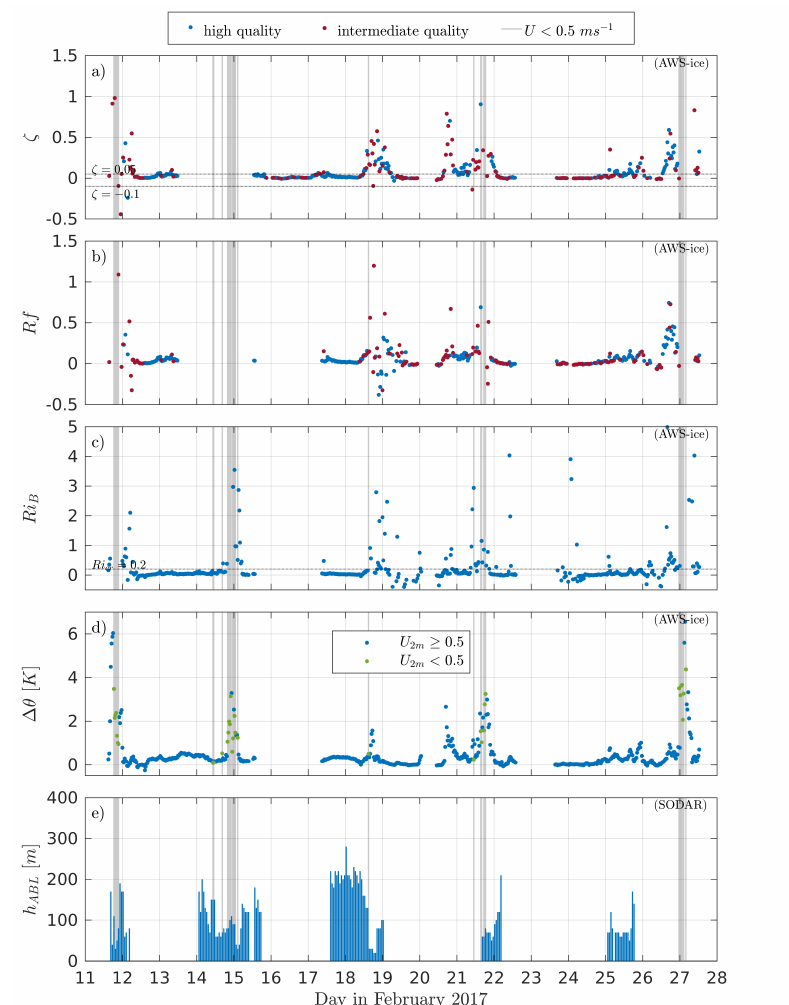
Figure 8. Time series of the stability parameters: ( a ) MO stabilty, ζ ; ( b ) flux Richardson Number, Rf ; ( c ) bulk Richardson Number, Ri B ; ( d ) the difference in potential temperature between the 4 m and 1 m levels, observed over the sea ice; and ( e ) the ABL height, h ABL , estimated from the SODAR (Sound Detection and Ranging) observations. The quality of the underlying eddy covariance (EC) data for ζ and Rf is indicated by blue and red markers. The horizontal dashed lines for ζ = − 0.1 and ζ = 0.05 in ( a ) and Ri cr = 0.2 in ( c ) mark the thresholds for different stability classes. The gray vertical lines mark near-calm events with U < 0.5ms − 1